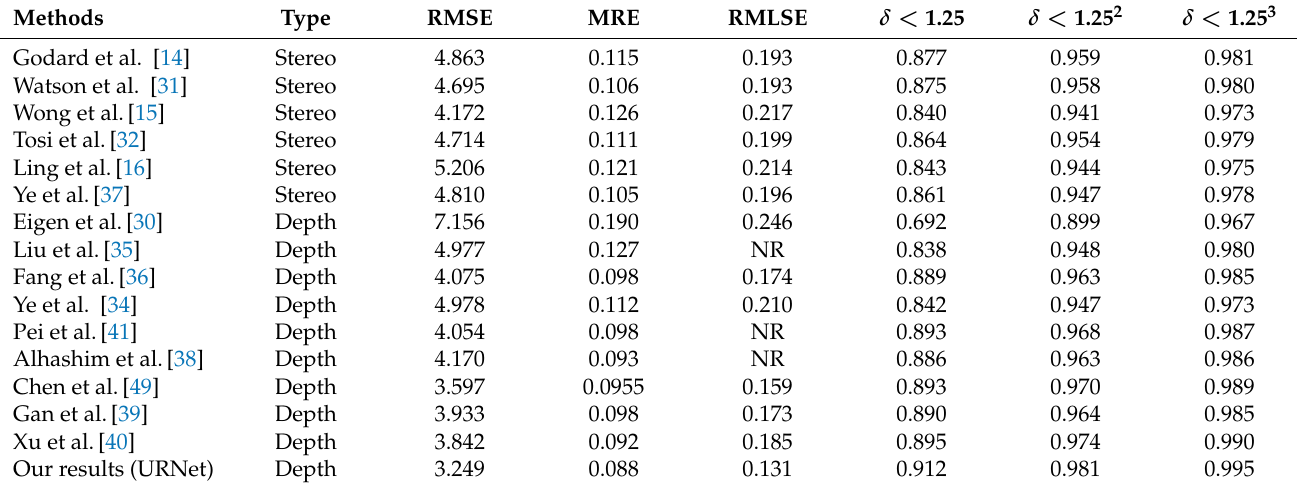
Table 2. KITTI dataset-based